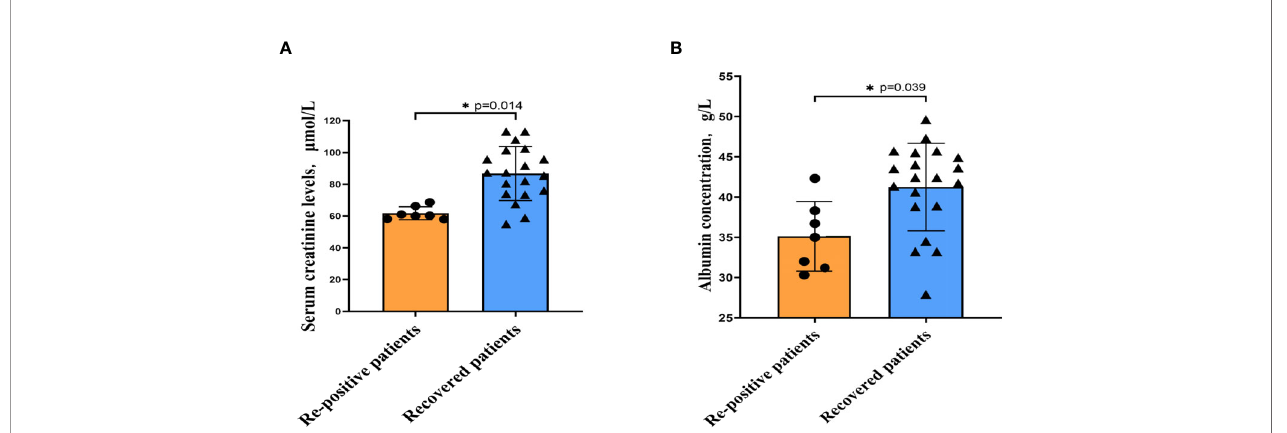
FIGURE 1 | The indicators of signi fi cant difference between patients with and without re-positive. Re-positive patients had lower serum creatinine concentrations (A) and albumin concentrations (B) at the time of initial admission than did recovered patients. Yellow represents the re-positive patients, and blue represents the recovered patients. All quanti fi cation graphs represent mean ±